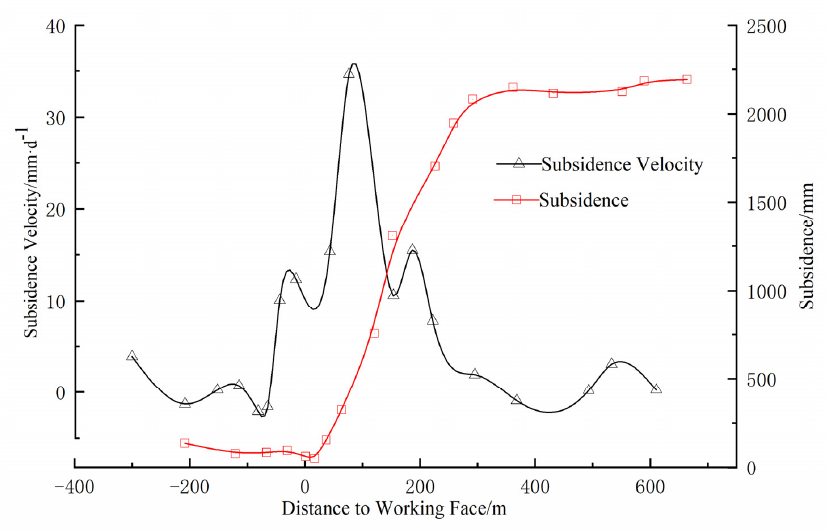
Figure 3. Subsidence velocity and subsidence curves of surface points with maximum subsidence.